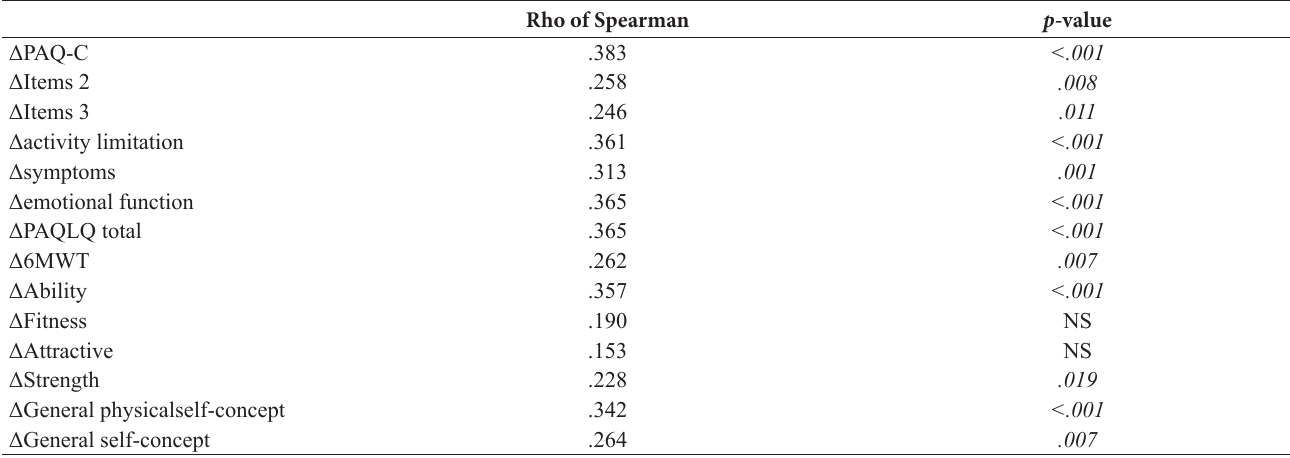
Table 3. Spearman correlation between physical activity enjoyment and the increase (post-pre differences) of variables analysed in this